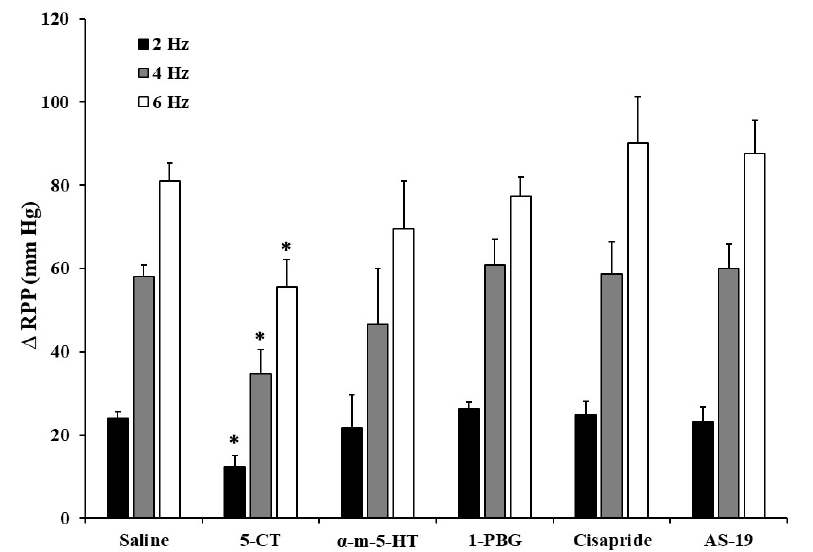
Figure 1. Effect of i.a. administration of serotonergic receptor agonists on the electrically induced increases in renal perfusion pressure in diabetic rats. Effect of i.a. bolus of saline (10 µ L) or the serotonergic receptor agonists 5-CT (5-HT 1/5/7 ), α -methyl-5-HT (5-HT 2 ), 1-PBG (5-HT 3 ), cisapride (5-HT 4 ), or AS-19 (5-HT 7 ) (0.4 µ g/kg each agonist) on the vasopressor responses elicited by electrical stimulation of renal sympathetic nerves in diabetic rats. * p < 0.05 vs. saline. α -m-5-HT, α -methyl-5- HT; 1-PBG,